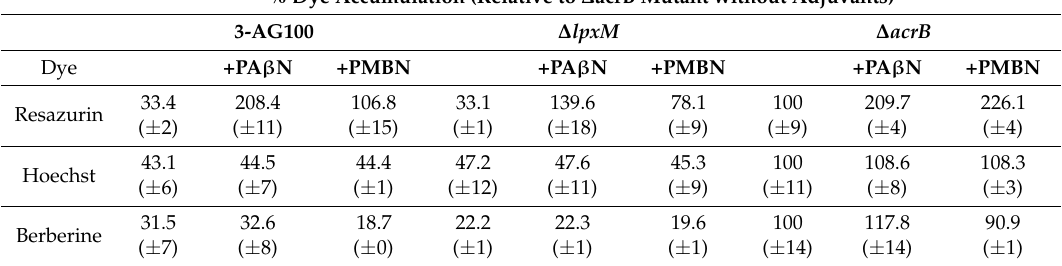
1 PA β N used at 25 mg/L, PMBN used at 10 mg/L. Values determined after 30 min of accumulation; SD of the mean given in parenthesis. Statistical significance proved for resazurin accumulation in the presence of PA β N and of PMBN vs. the absence of adjuvants in all strains, and for berberine accumulation with mutant ∆ acrB (in the presence of PA β N vs. accumulation without adjuvants); p -values < 0.01; n = 7, assays with PMBN, n ≥